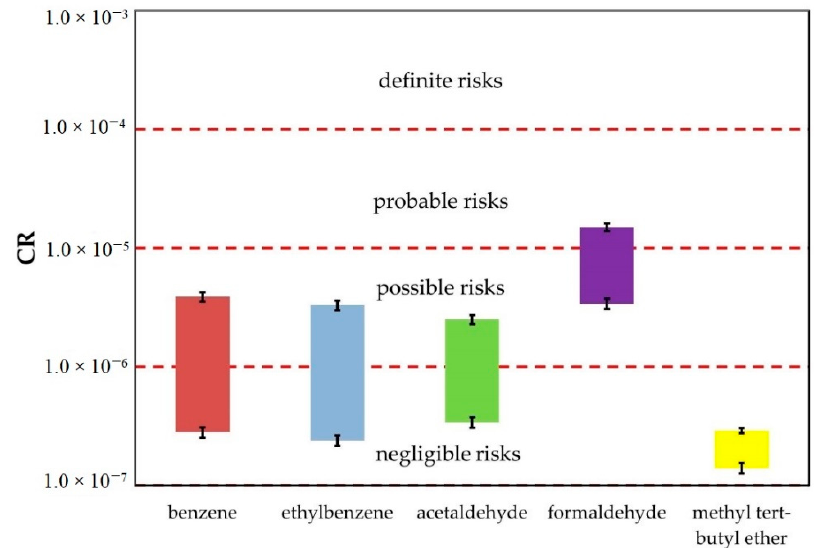
Figure 2. Ranges of cancer risk (CR) parameter determined based on investigations performed in both 2017 and 2018.